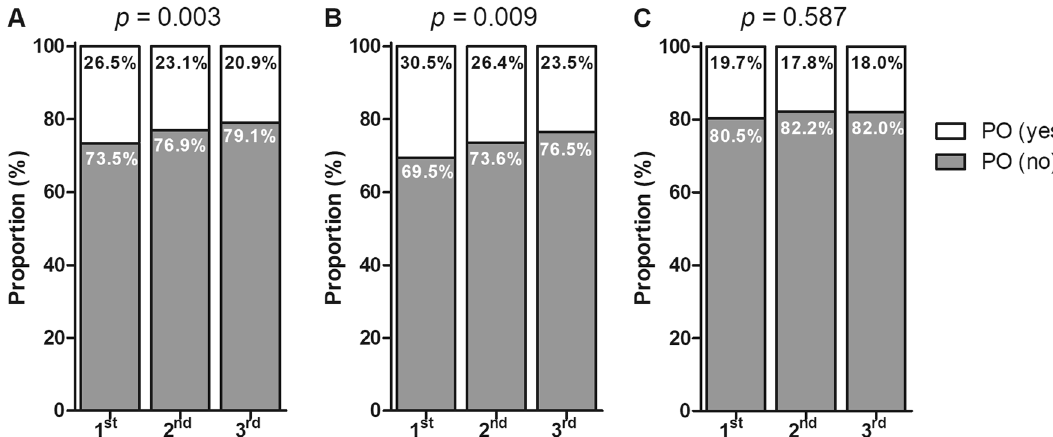
Figure 2. Weighted prevalence of periodontitis according to TSH tertiles in ( A ) all participants, ( B ) males, and ( C ) females. Abbreviations: PO, periodontitis; TSH: thyroid stimulating hormone.